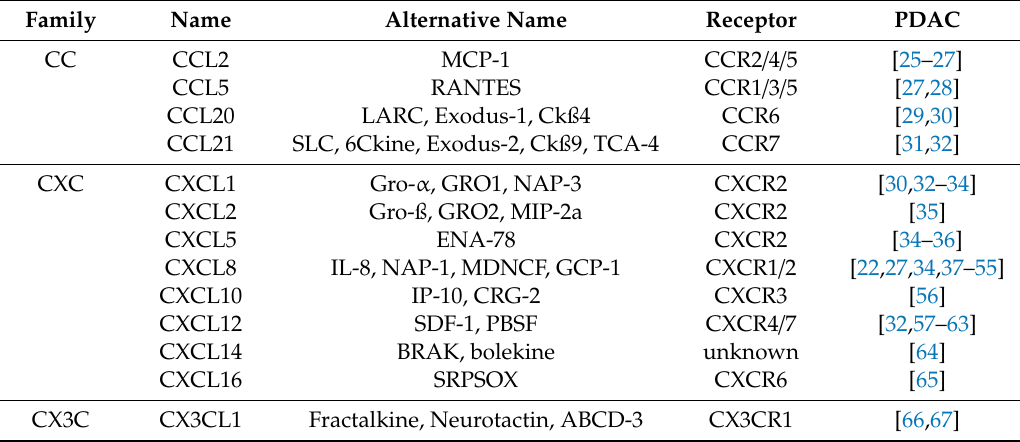
Table 2. Chemokine / NF- κ B pathway interactions in PDAC with the corresponding literature.